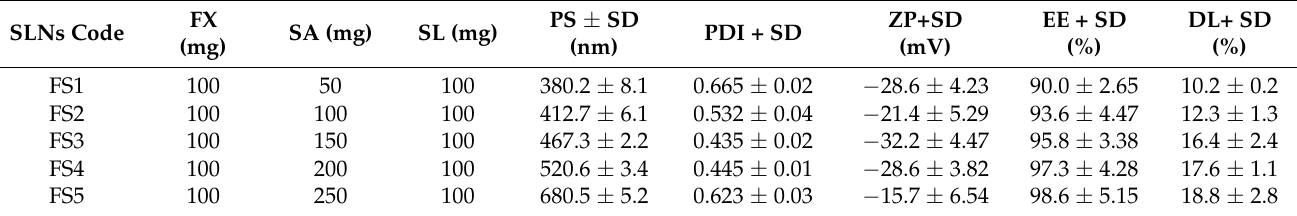
Figure 2. Zeta potential of the optimized FS3. Table 1. Composition of fluoxetine-loaded SLNs and evaluation